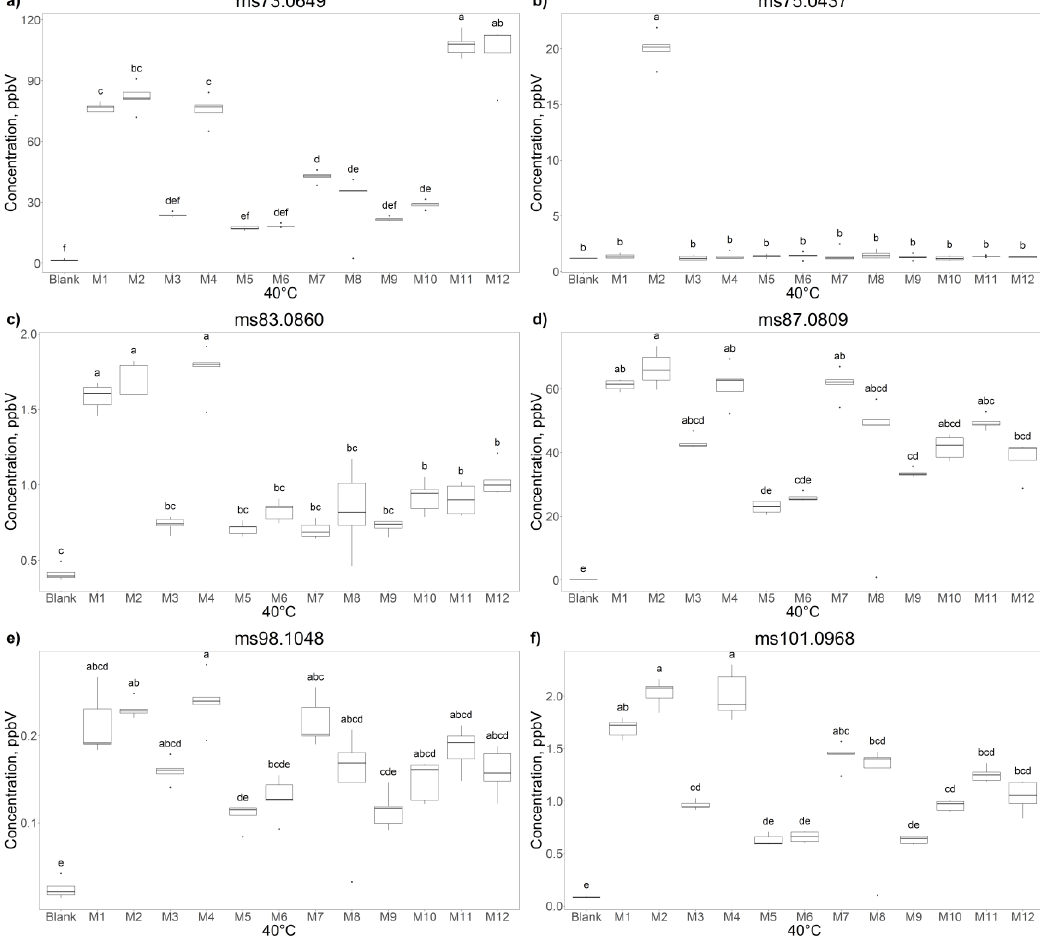
Figure 2. The boxplots indicated by letters ( a )–( f ) represent selected volatiles found in association with the different commercial mascarpone samples such as m/z 73.0649—C 4 H 9 O + —t.i. 2-Butanone, 75.0437—C 3 H 7 O 2+ —t.i. Methyl acetate, 83.0860—C 6 H 11+ —t.i. fragment of Hexanal/Hexenol, 87.0809—C 5 H 11 O + —t.i. 2-Pentanone/3-Buten-1-ol, 3-methyl-, 98.1048—isotope of C 7 H 13+ —t.i. Heptanal, 101.0968—C 6 H 13 O + —t.i. 2-Hexanone. Different letters indicate a significant difference